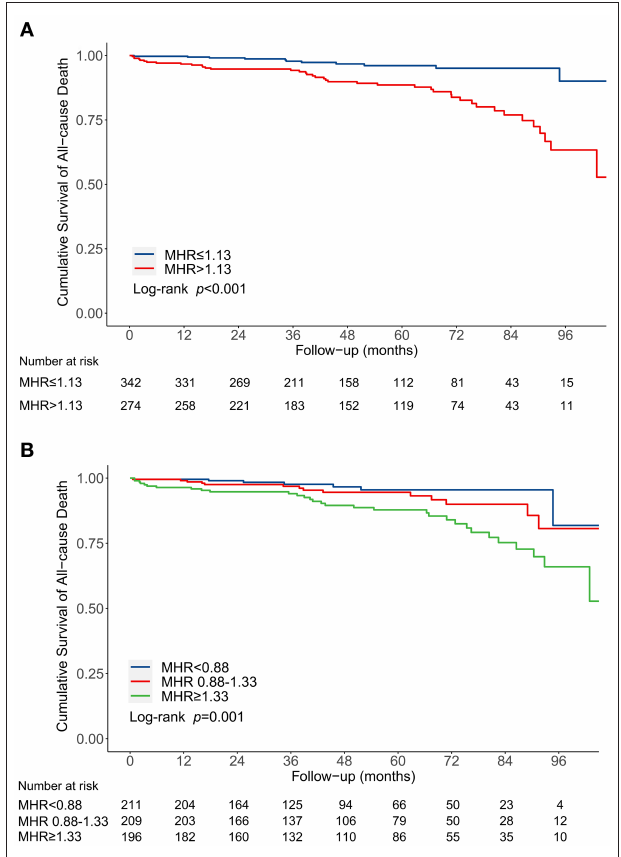
FIGURE 3 | Kaplan-Meier curve for cumulative survival rates of long-term mortality before propensity score matching. (A) Classified by the receiver operating characteristic curve selected cut-off of MHR. (B) Classified by the tertiles of MHR. MHR, monocyte to high-density lipoprotein